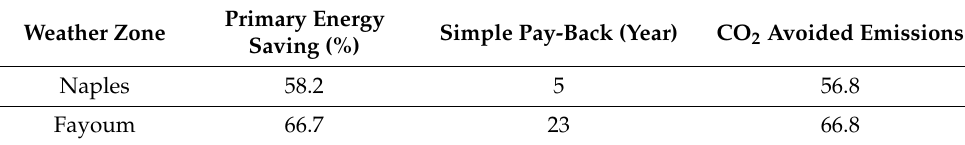
Table 1. Energy saving and payback in Naples and